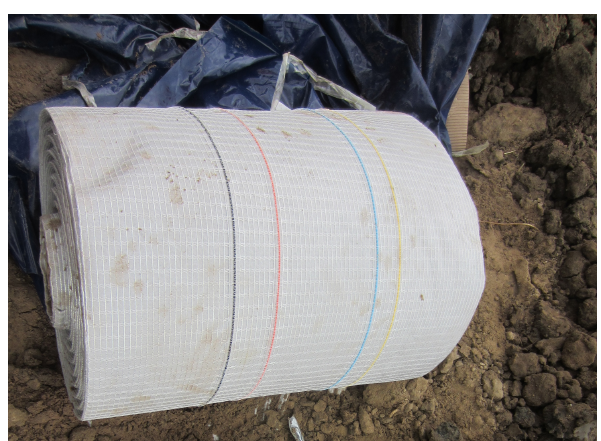
Figure 4. Geotextile strip encasing two single-mode and two multi- mode optical fibres (courtesy of